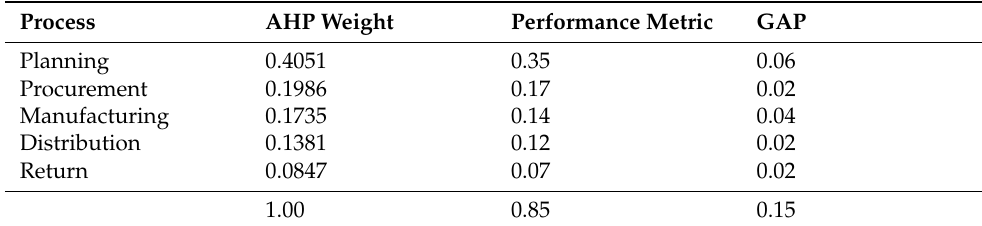
Table 8. Supply chain performance GAPs at the sector level by process.